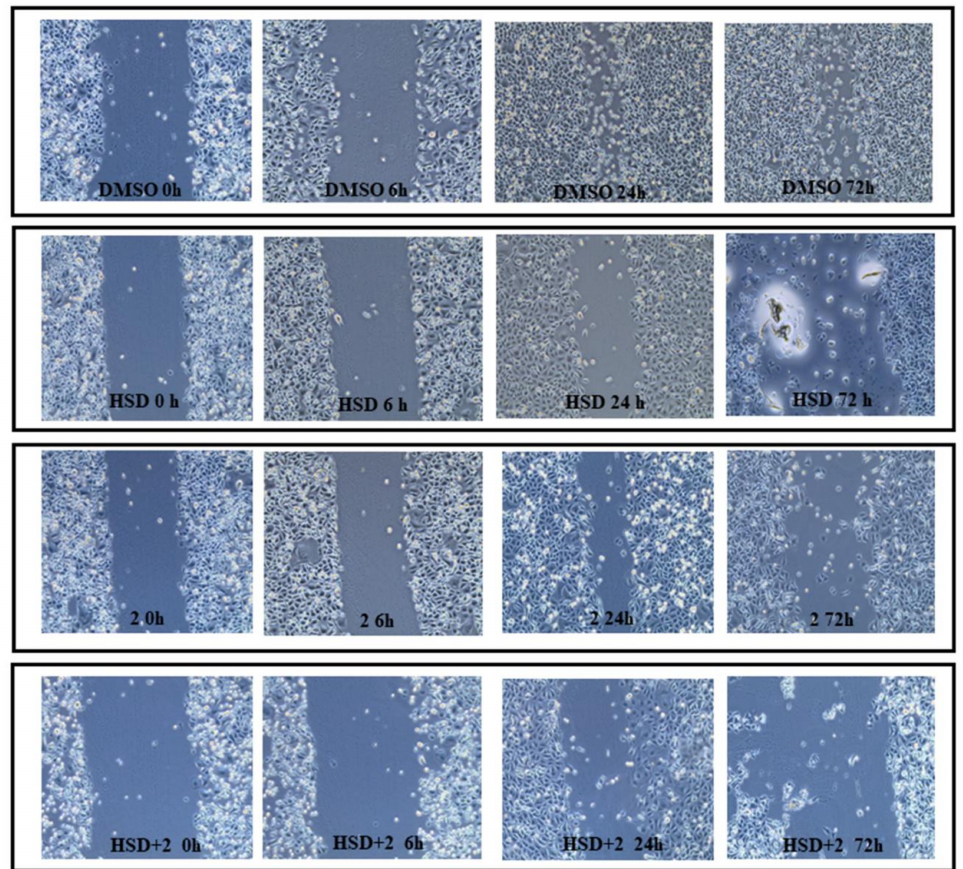
Figure 11. Scratch wound-healing assay was performed in AGS cells treated with HSD (180 µ M), 2 (1 µ M), and HSD+ 2 . Images were taken at 0, 6, 24, and 72 h after confluent monolayer of cells was wounded. DMSO 0.5%: control vehicle. The most representative of three separate experiments is shown.